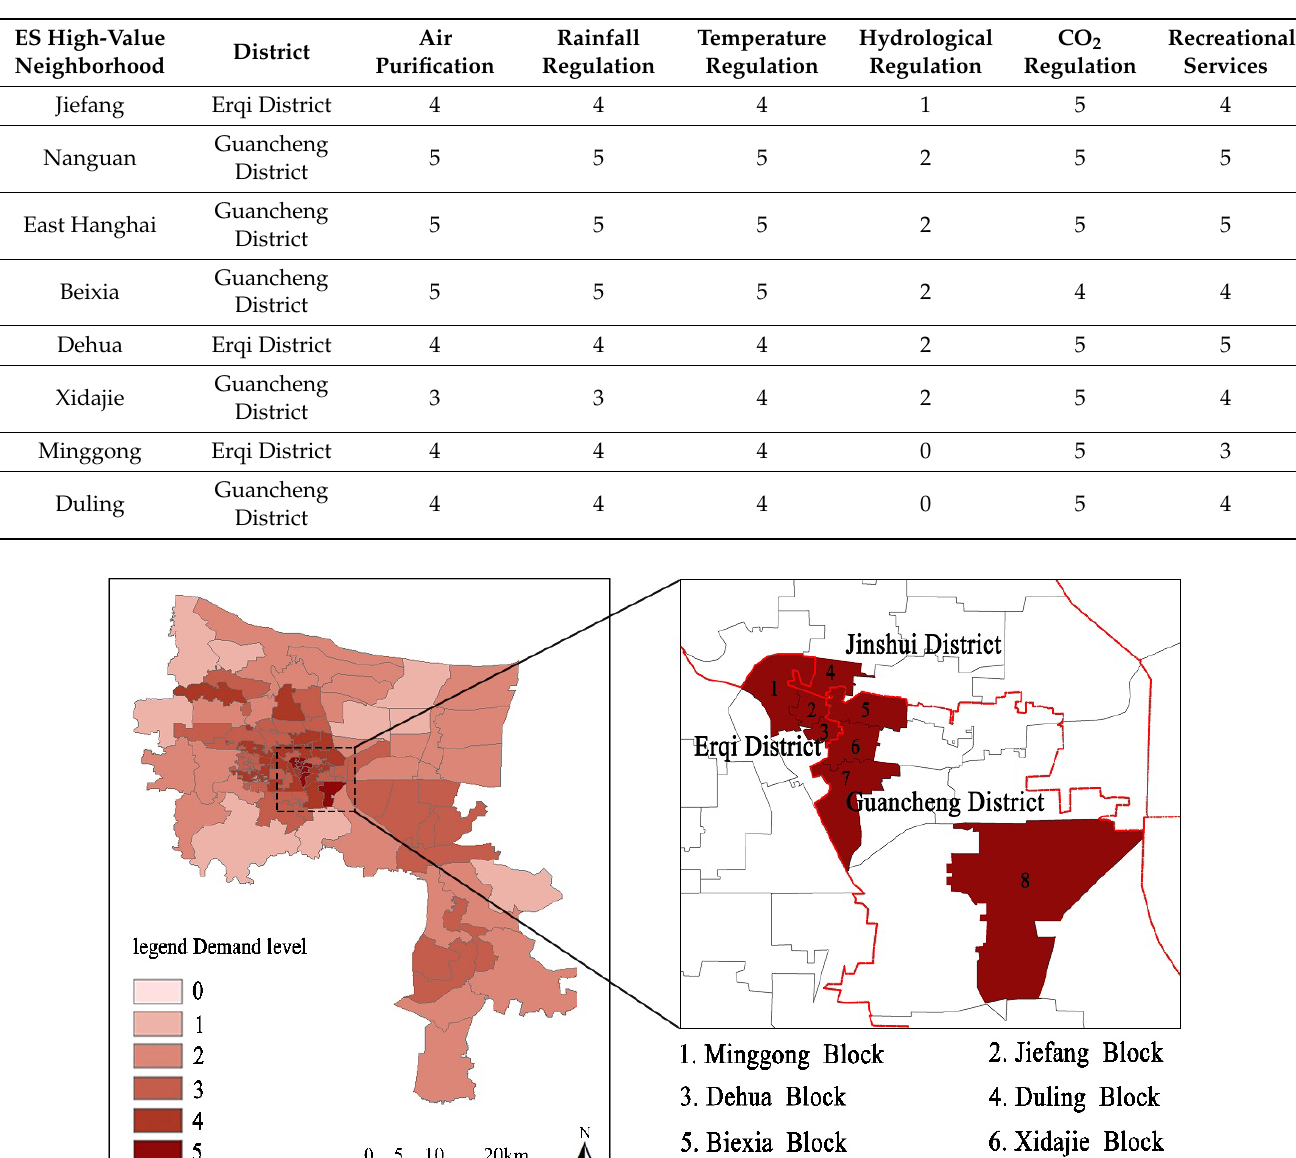
Table 2. High, comprehensive ES excessive demand blocks.